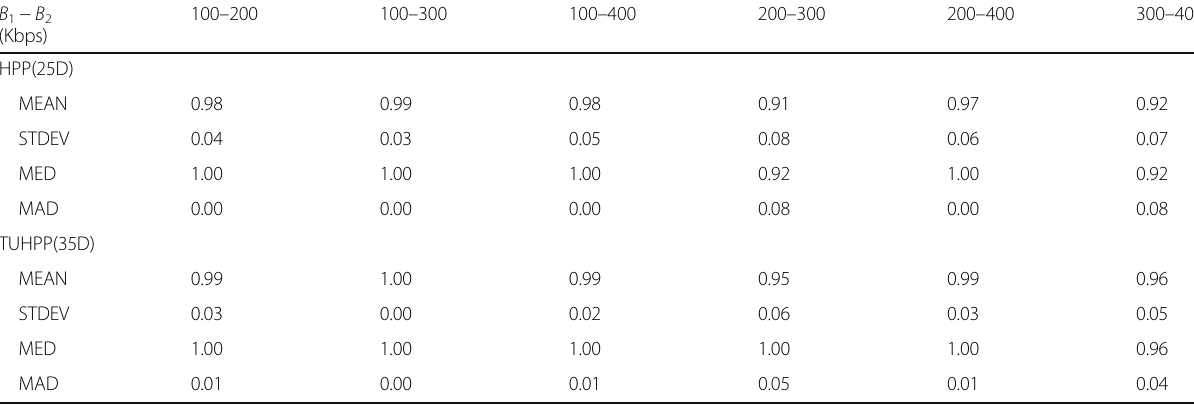
Table 4 Detection accuracy of the double compressed video fragments from its corresponding single compressed ones using HPP feature and TUHPP feature on QCIF video